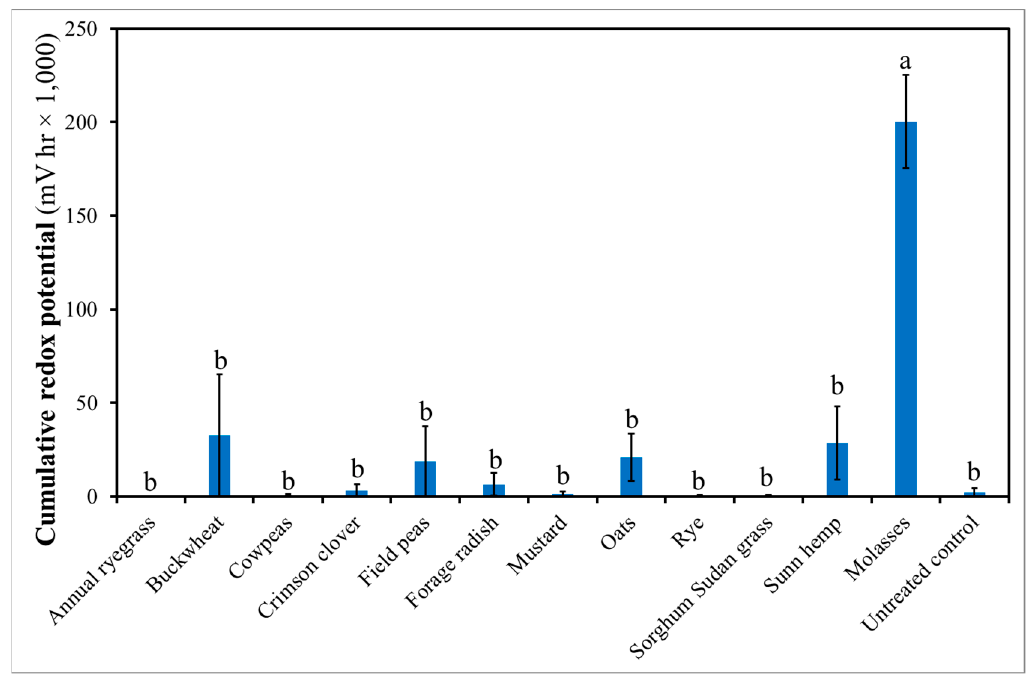
Figure 2. Cumulative redox potential at 28 days after treatment. Values are means with standard errors ( n = 3). Data were subjected to ANOVA and differences among means were determined by errors ( n = 3). Data were subjected to ANOVA and di ff erences among means were determined by Student–Newman–Keuls post hoc multiple comparison procedure. Different letters represent Student–Newman–Keuls post hoc multiple comparison procedure. Di ff erent letters represent statistical statistical differences for p < 0.05. di ff erences for p <